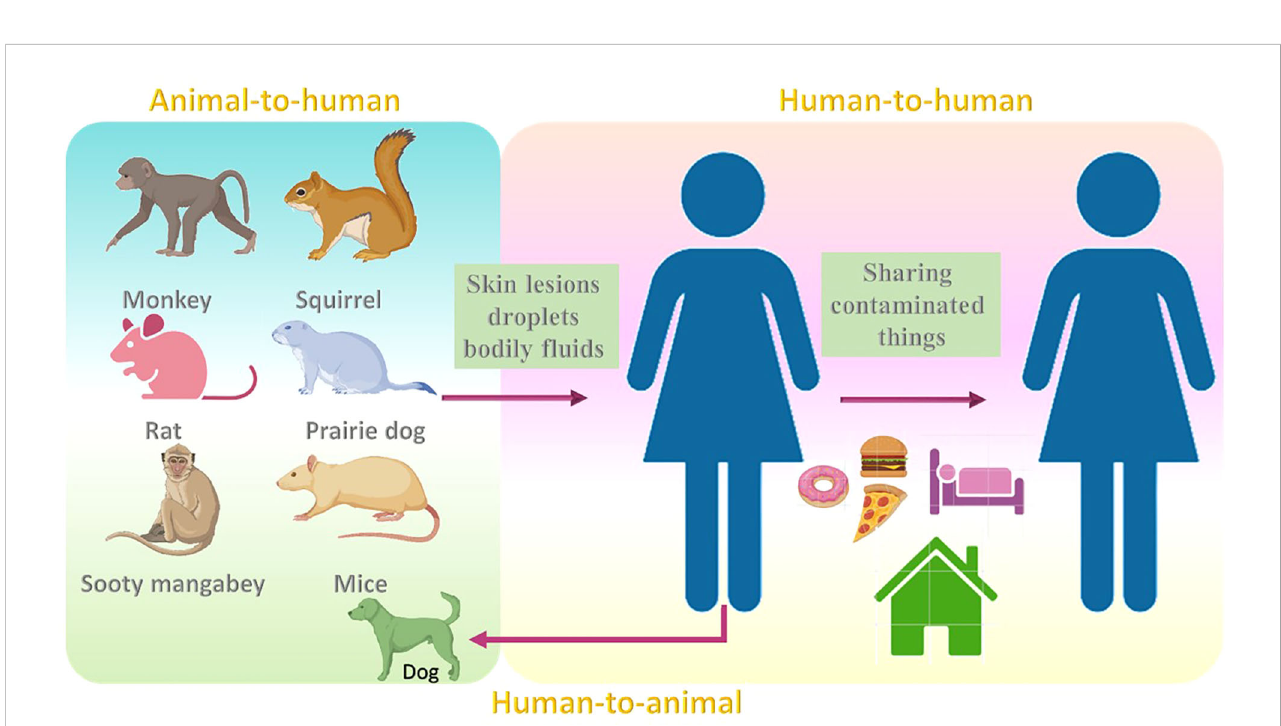
FIGURE 3 Transmission modes of MPV from animals (reservoirs) to humans and humans to animals.